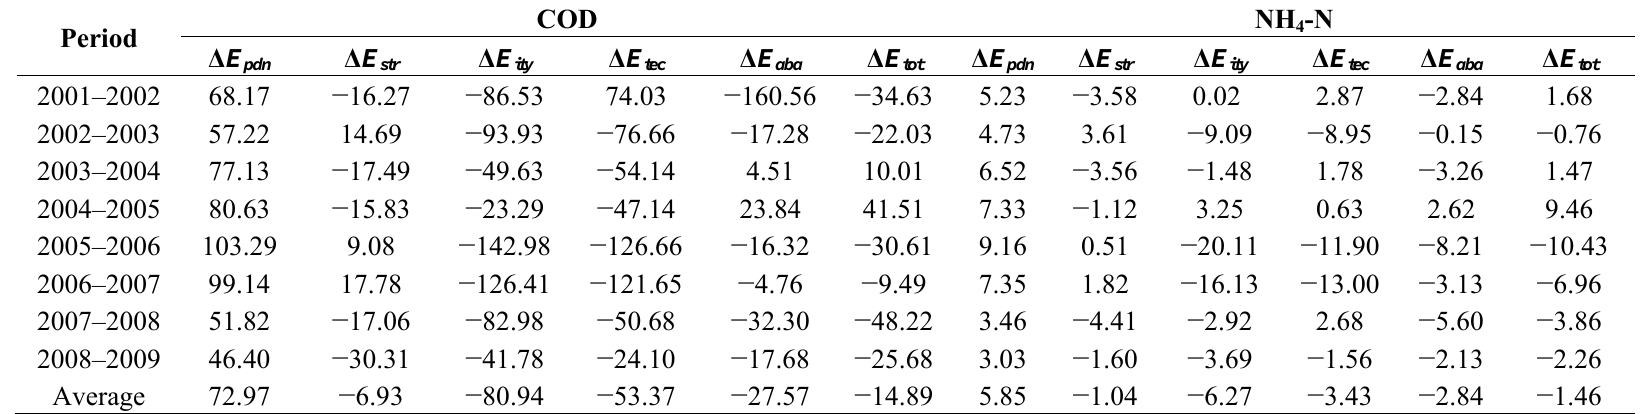
-N discharges (Unit: 10 4 t). 4